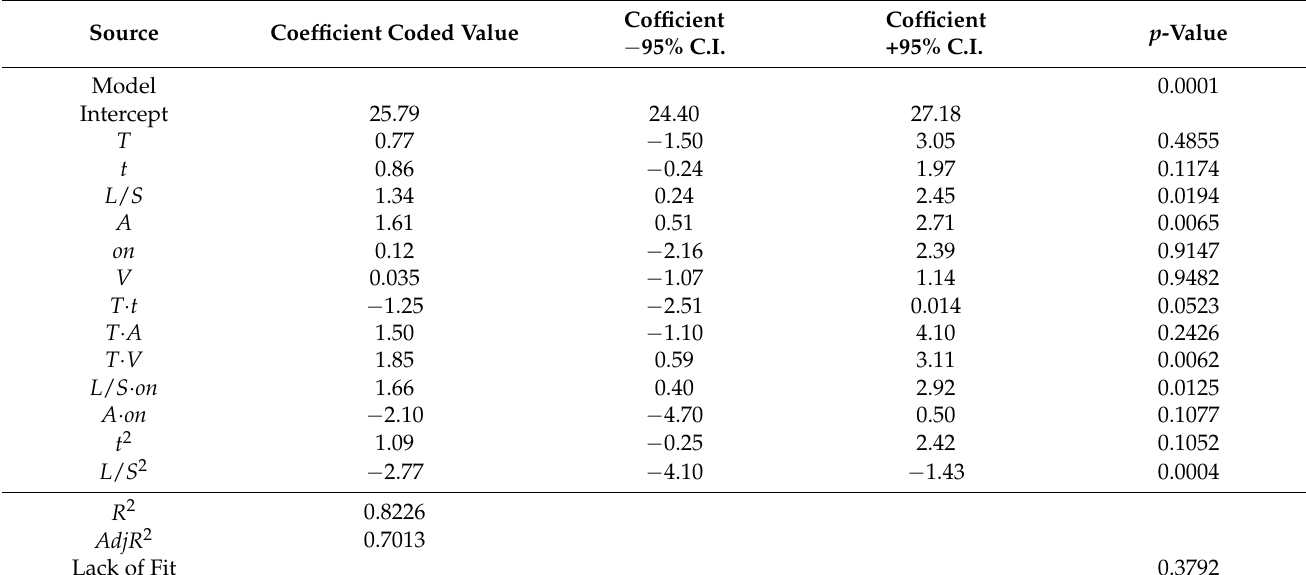
Table 3. Model for lycopene yield ( LY ) as a function of input variables and analysis of